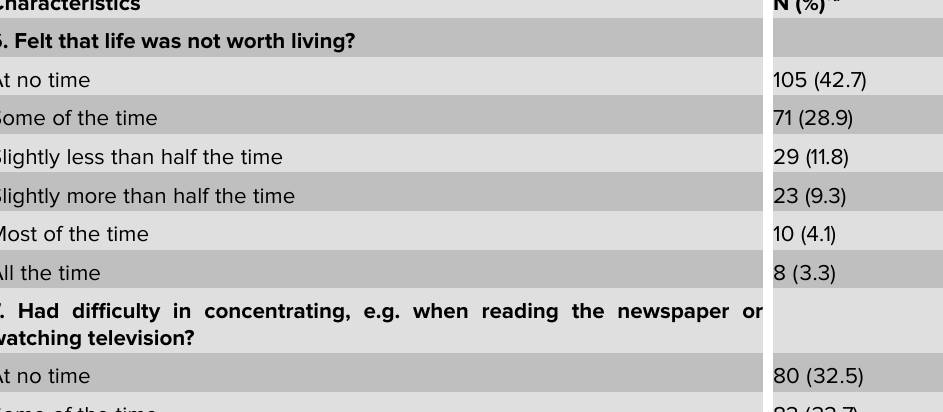
Table 3: MDI questions for